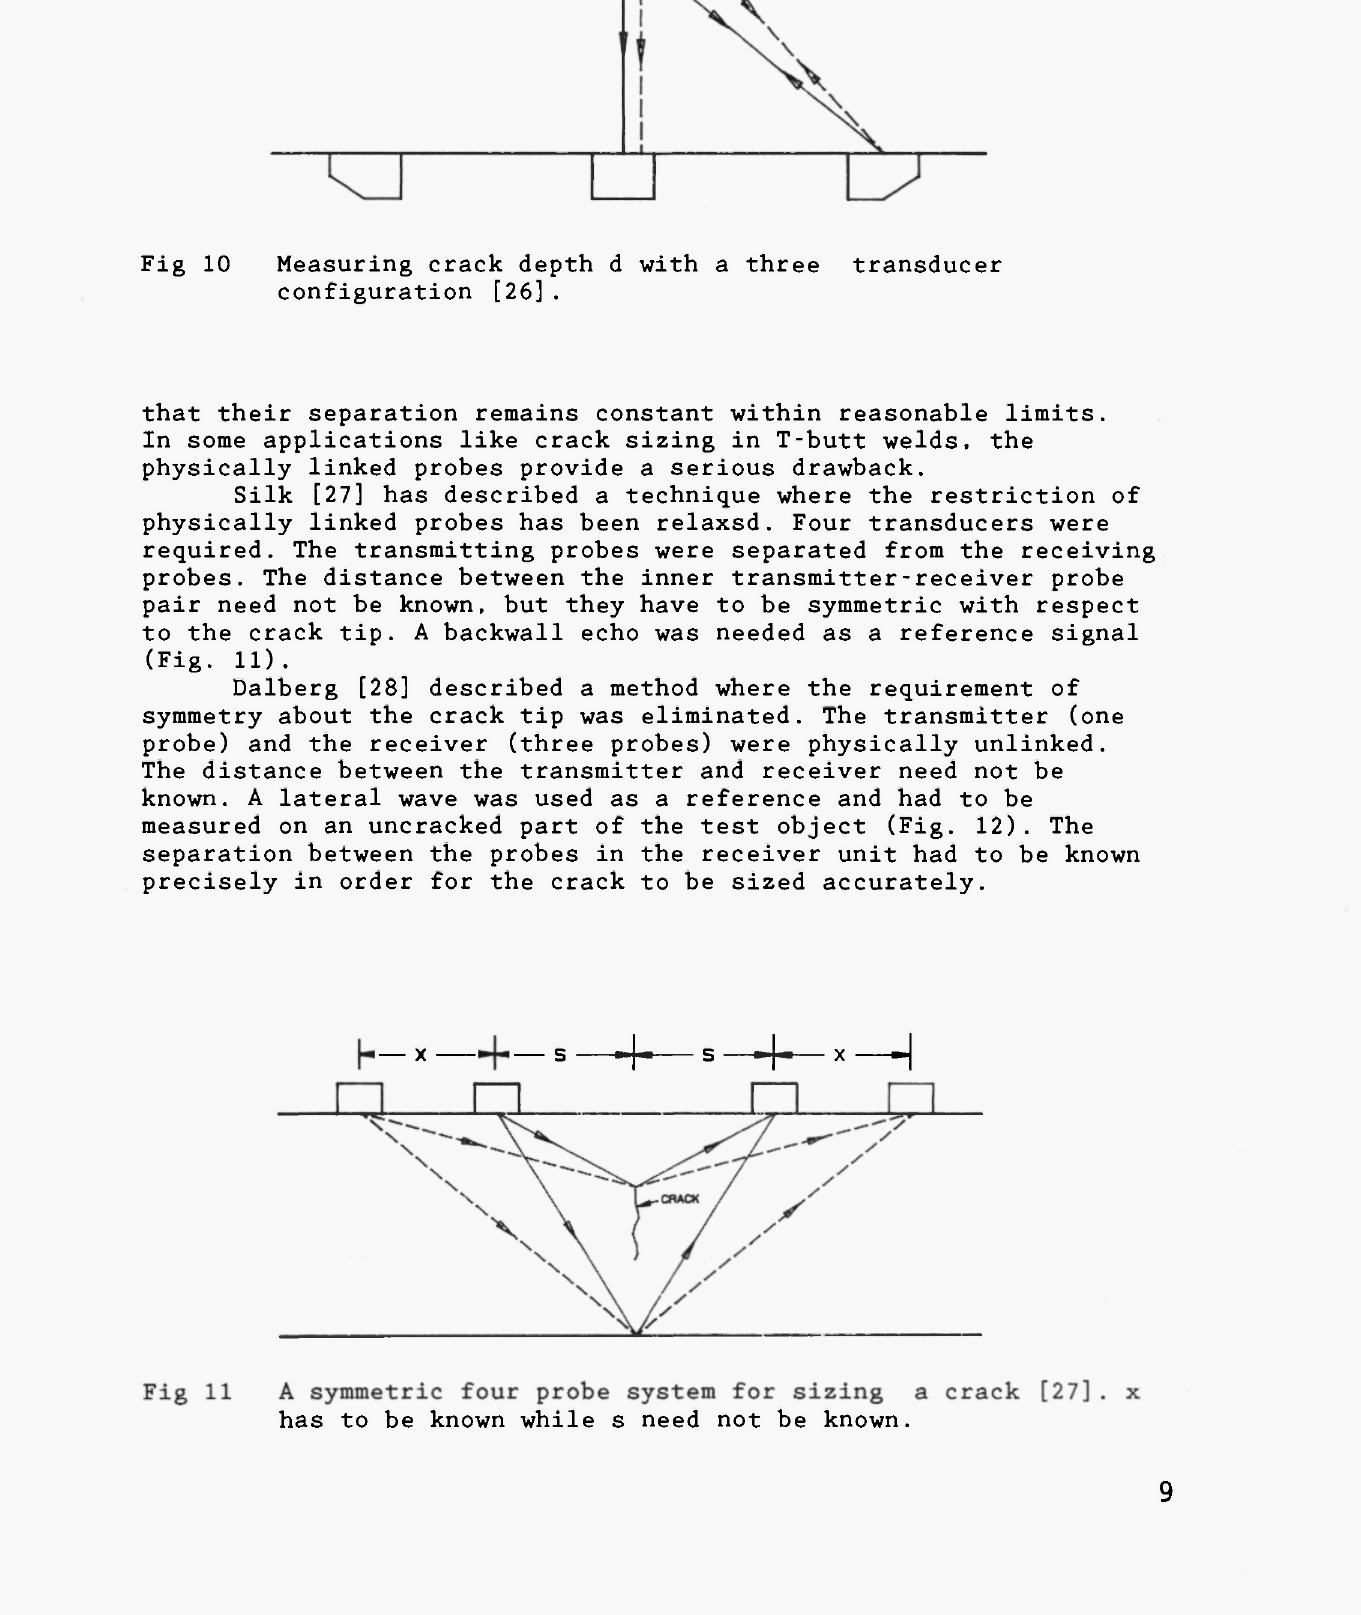
Fig 10 Measuring crack depth d with a three transducer configuration [26].